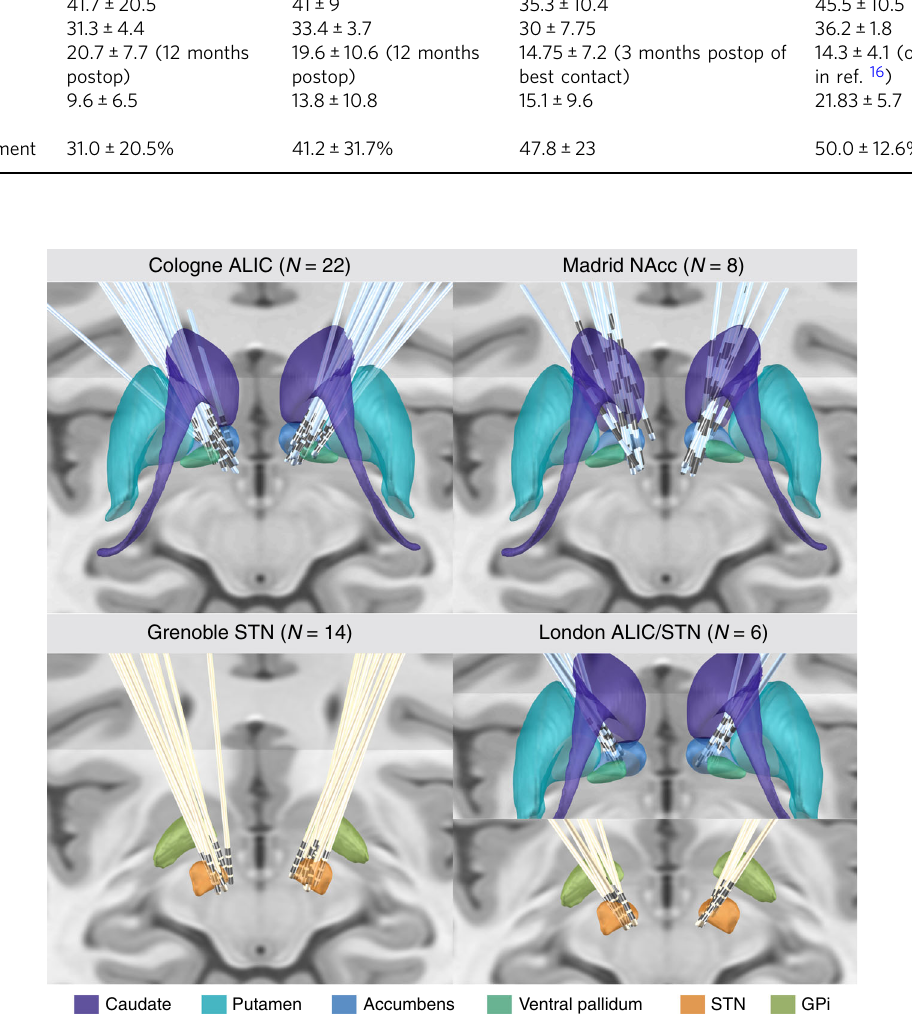
Fig. 1 Overview of lead electrode placement. The two training/cross-validation cohorts (left) targeting ALIC (Cologne) and STN (Grenoble), and the two test cohorts (right) targeting NAcc (Madrid) and both ALIC & STN with four electrodes per patient (London) are shown. Subcortical structures de fi ned by CIT-168 Reinforcement Learning Atlas 63 (ALIC/NAcc region) and DISTAL Atlas 64 (STN region), with coronal and axial planes of the T1-weighted ICMB 152 2009b nonlinear template as